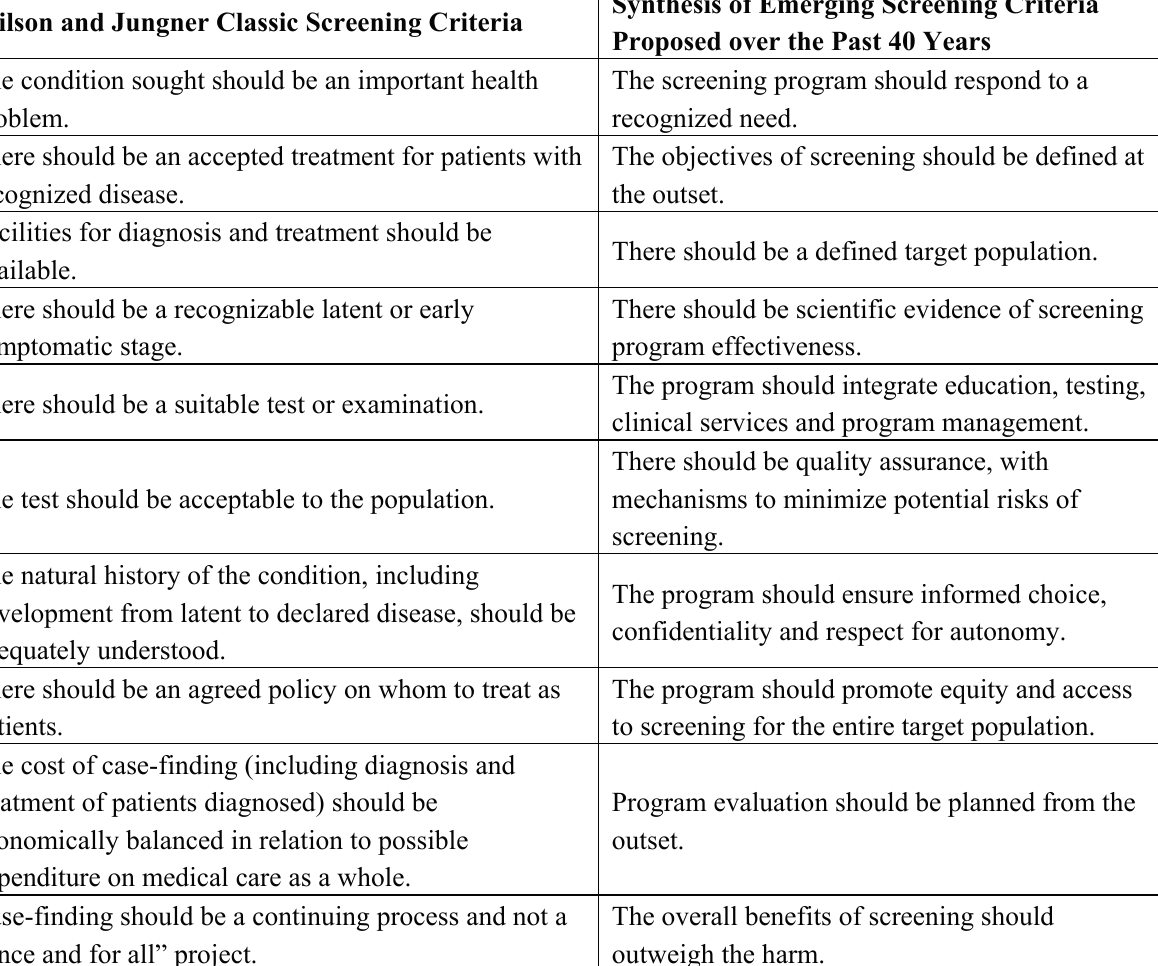
Table 1. Updated Wilson-Junger screening criteria